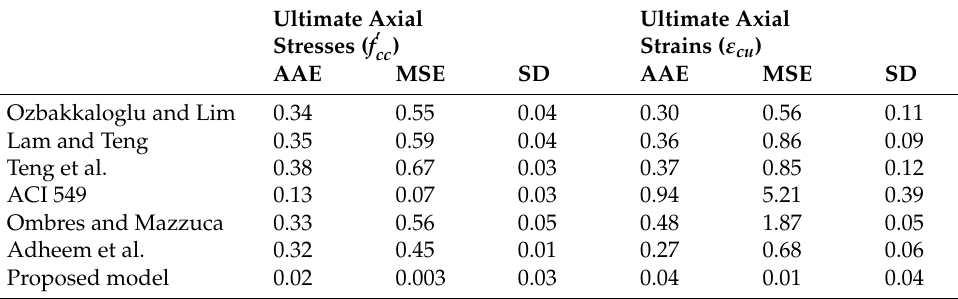
Table 5. Comparing the accuracy of the proposed model and classical